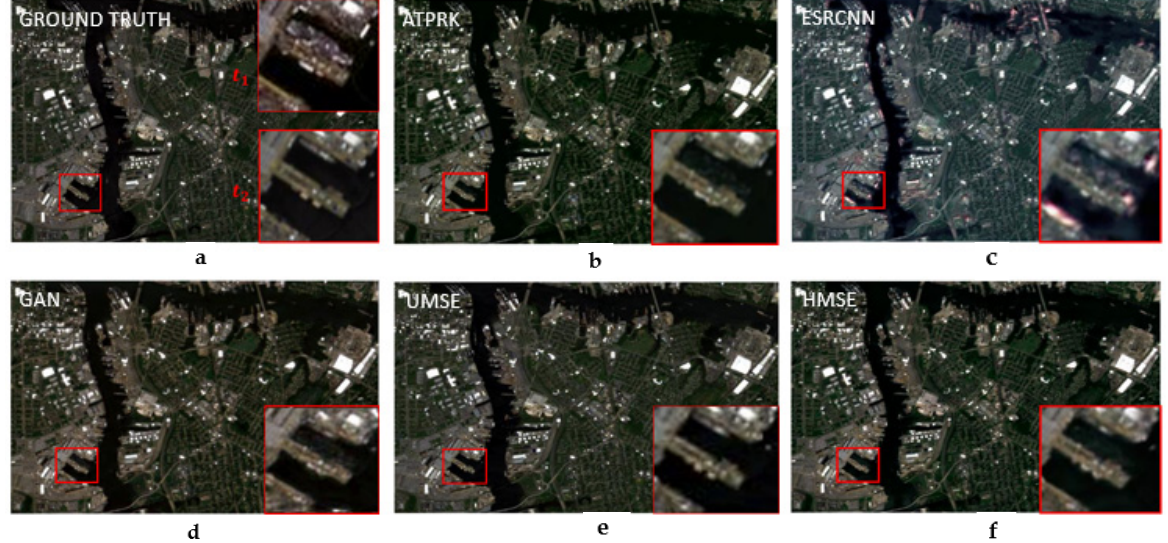
Figure 8. Image fusion results with temporal changes. From left to right, the first row ( a – c ) shows the ground-truth image, ATPRK, and ESRCNN; and the second row ( d – f ) shows GAN, UMSE, and HMSE, respectively. In the ground truth image, the zoomed-in regions at t 1 and t 2 show changes captured by the Sentinel-2 satellite image where a cargo ship docked in the Norfolk port at t 1 and left at t 2 . The ESRCNN failed to reflect the change in the fused image. ATPRK, GAN, and our models successfully captured this change in the fused images. UMSE: “U-Net + MSE”. HMSE: “HRNet + MSE”.